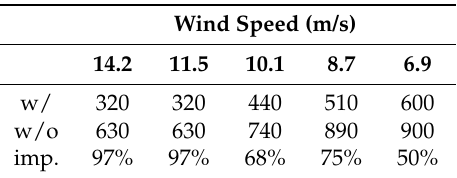
Table 4. CCT (ms) results under different wind